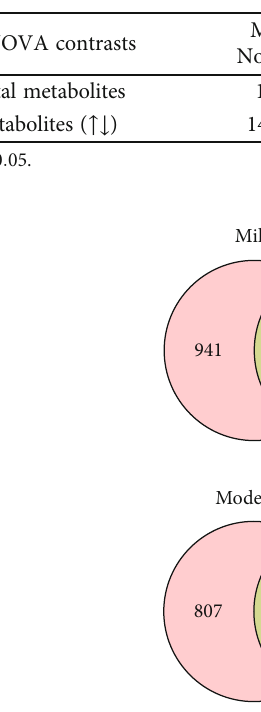
Figure 1: Venn diagrams to visualize the di ff erentially expressed metabolites identi fi ed by di ff erent phenotype between the groups according to degree of renal function.